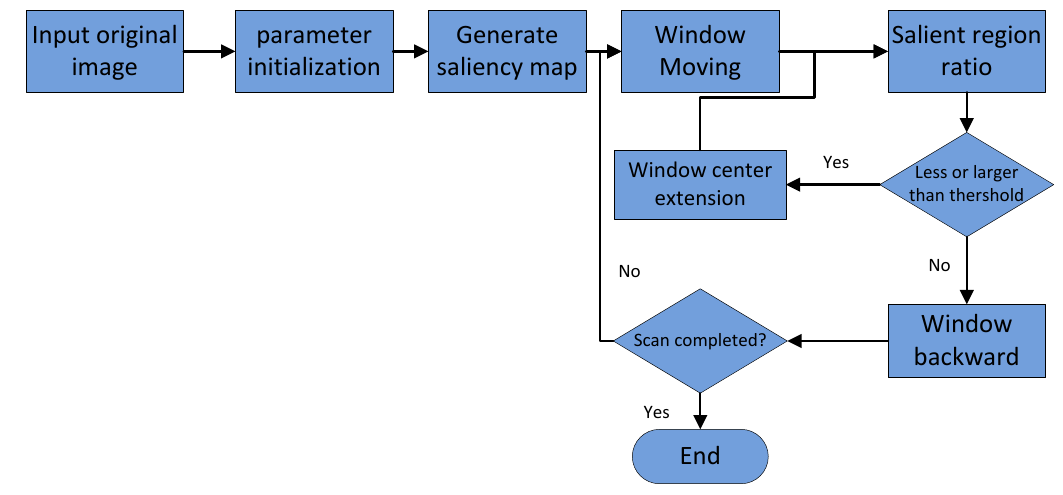
Figure 3. Saliency map-based window calibration.